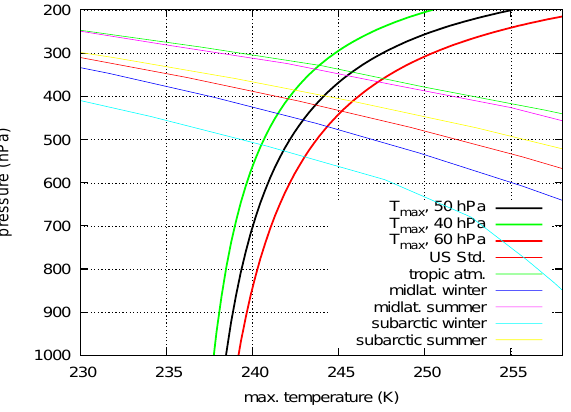
Fig. 1. Pressure differences ∆ p above minus below the wings of various aircraft representing more than half of European air traffic in 2011. ∆ p has been calculated by dividing weight by wing area. Error bars around a central reference value indicate pressure differences at maximum and minimum weights. Maximum flight altitudes in feet and corresponding pressure altitudes are given on the vertical axes. The aircraft types are: A320 (AIRBUS A-320), B738 (BOEING 737-800), A319 (AIRBUS A-319), A321 (AIRBUS A-321), DH8D (DHC-8-400 DASH), B733 (BOEING 737-300), AT72 (ATR-72-200), B737 (BOEING 737-700), E190 (EMBRAER ERJ-190), B735 (BOEING 737-500). Source: EUROCONTROL (1) EEC Technical/Scientific Report No. 12/06/21-55, 2012, and (2) BADA data base (V327).